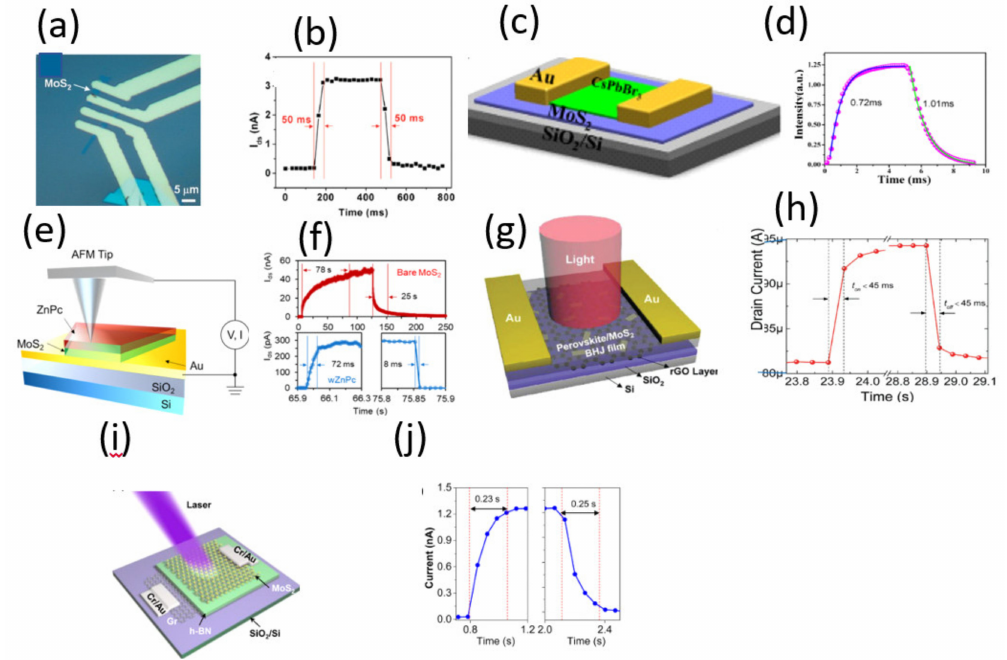
Figure 10. ( a , b ) Optical image of FET device made by single-layer MoS 2 and photo-switching rate. Reproduced with permission from reference [107]. ( c , d ) Schematic illustration of the hybrid MoS 2 / CsPbBr 3 photodetector and temporal photocurrent response of the hybrid device. Reproduced with permission from reference [108]. ( e , f ) Schematic of the conductive AFM measurement and time-dependent photoresponse dynamics for a MoS 2 device after varied ZnPc treatments plotted on a linear scale. Reproduced with permission from reference [109]. Copyright 2018, American Chemical Society. ( g , h ) Device structure of the hybrid photodetector based on perovskite / MoS 2 BHJ on rGO and photo-switching characteristics of the perovskite / MoS 2 BHJ-rGO hybrid photodetector measured alternately in dark and under 660 nm light illumination (1 mW cm − 2 , VGS = 0 V, VDS = 2 V). Reproduced with permission from reference [110]. ( i , j ) Optical images of the device (scale bar: 10 µ m), Dynamic photoresponse obtained from device. Reproduced with permission from reference [111]. QD-MoS 2 hybrids with interfacial interaction dominated by charge transfer (left) and by non-radiative energy transfer (right), Time-resolved analysis of the normalized rise times of photocurrent at V G = − 40 V and V DS = 0 V under 488 nm laser with 37 µ W. Reproduced with permission from reference [112]. ( i , j ) Schematic of the MoS 2 / BN / graphene hetero-structure photodetector for photon absorber / selective hole tunneling layer / bottom electrode, respectively and Time-resolved photoresponse of the 7 h-BN nm device under 405 nm laser irradiation. Reproduced with permission from reference